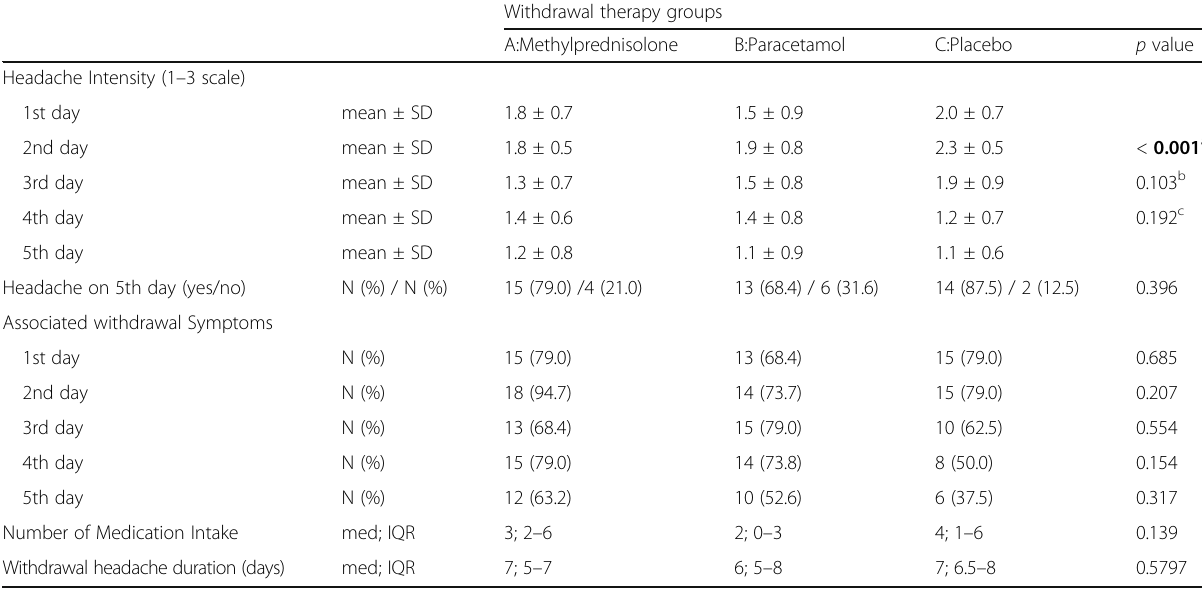
Table 2 Clinical features of patients randomized to the three different detoxification groups during the withdrawal program Withdrawal therapy groups A:Methylprednisolone